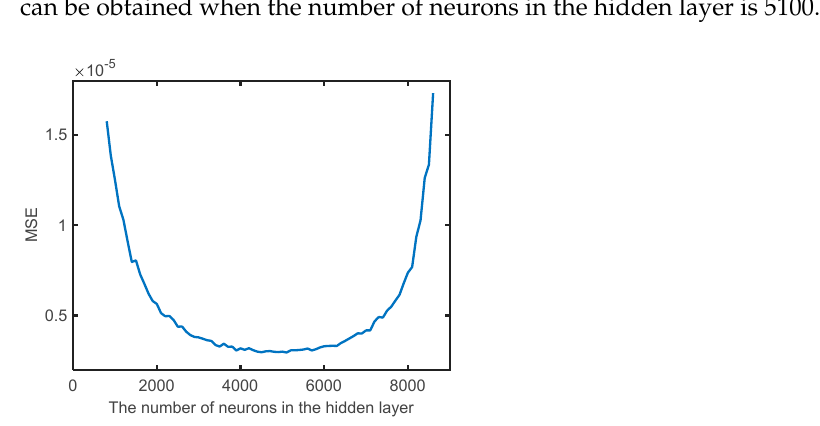
Figure 4. The predictive accuracy of the ELM model under different numbers of neurons in the hidden layer.